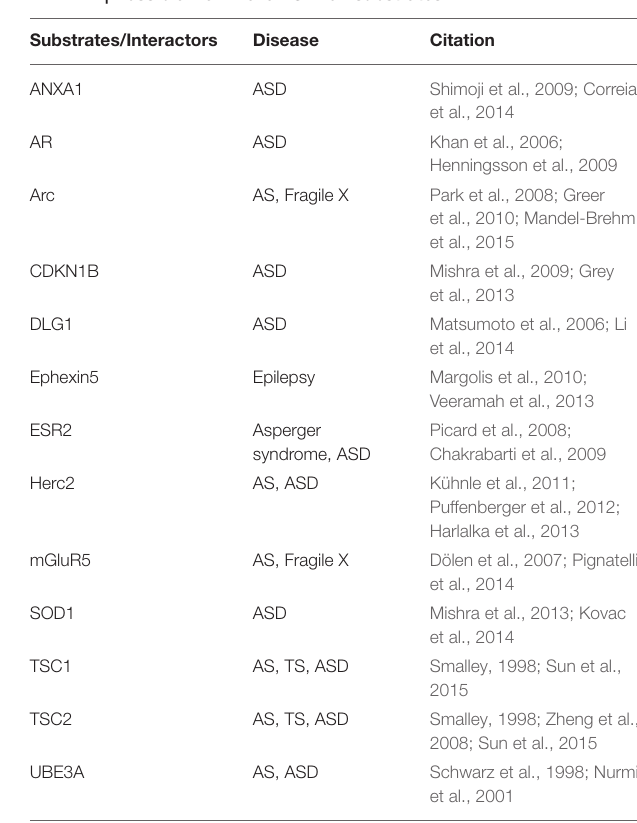
TABLE 1 | Possible mammalian UBE3A